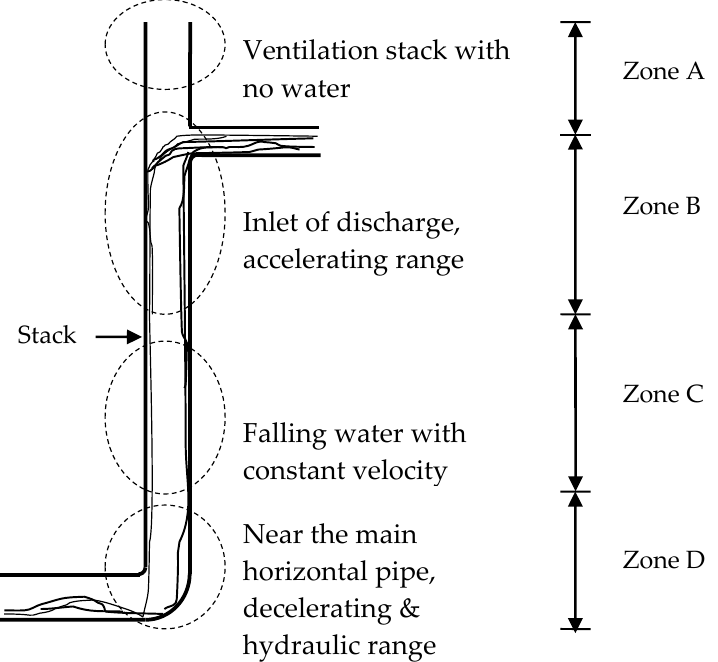
Figure 1. Four zones in a discharging drainage stack.